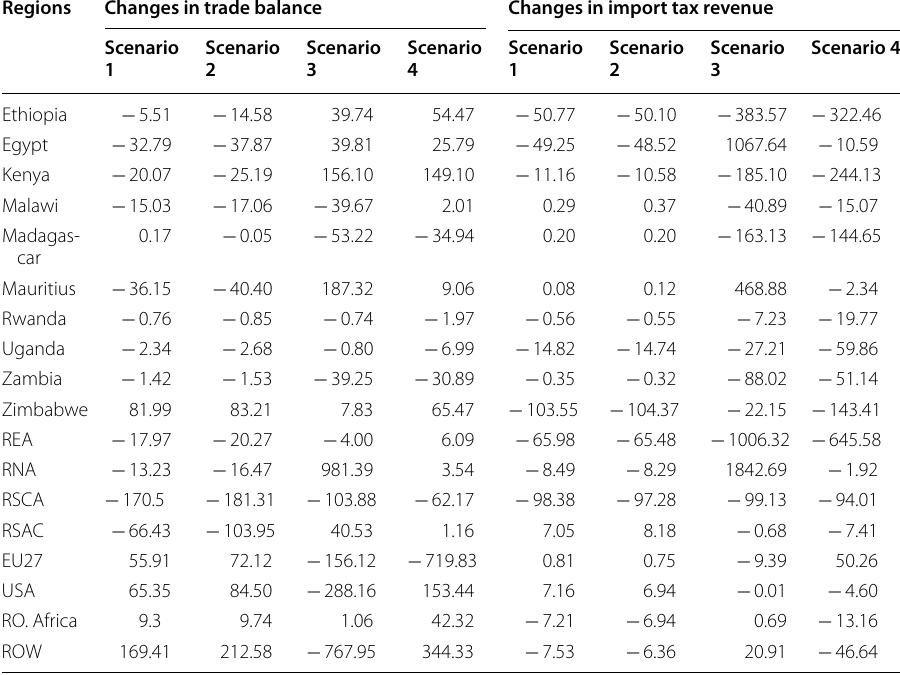
Table 10 Changes in trade balance and import tax revenue (US$ million). Source: Model Simulation